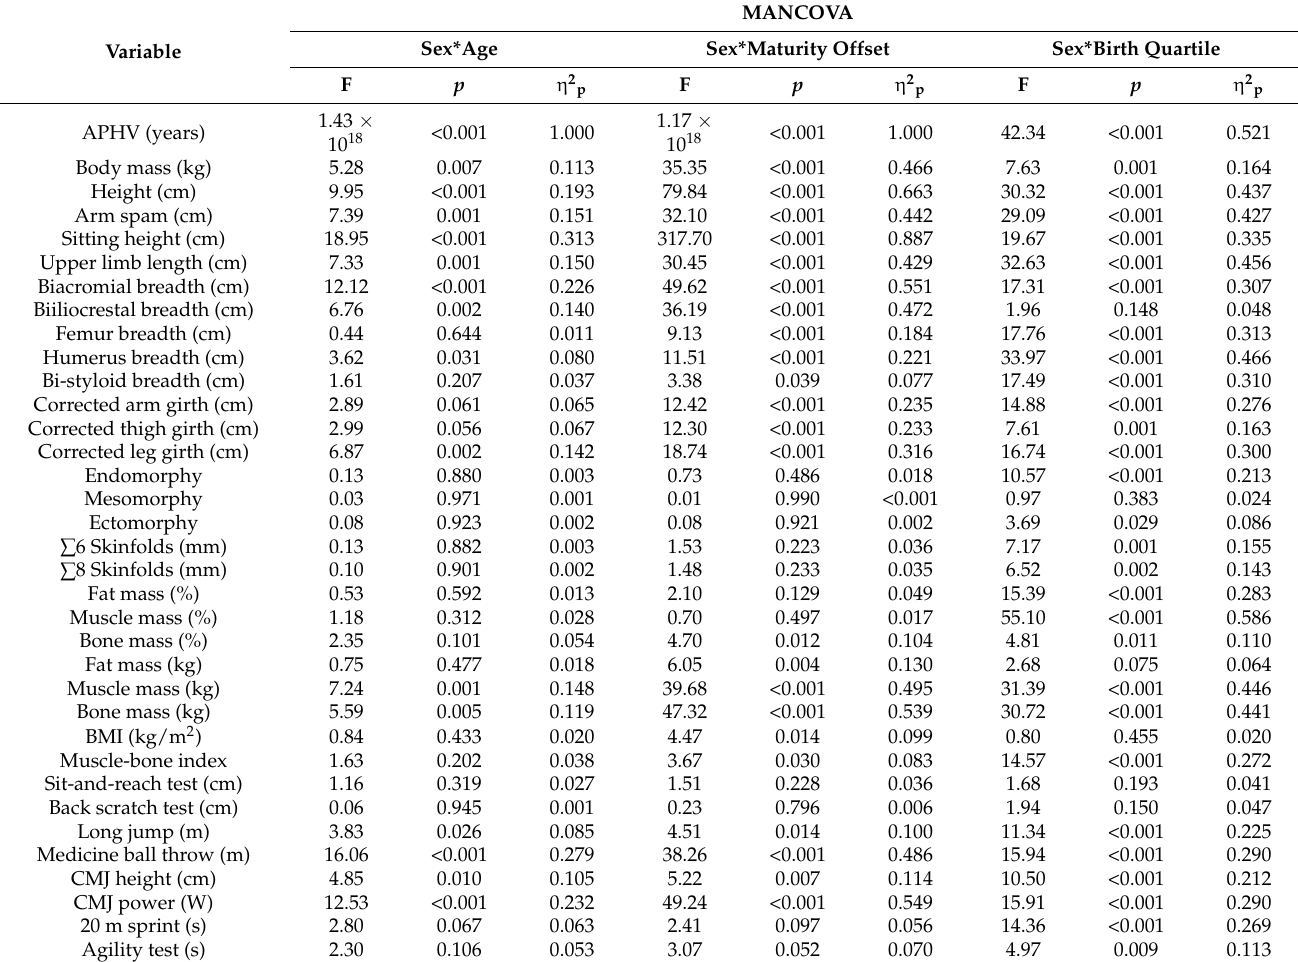
Table 2. Interaction between sex groups and the covariables age, maturity offset and birth